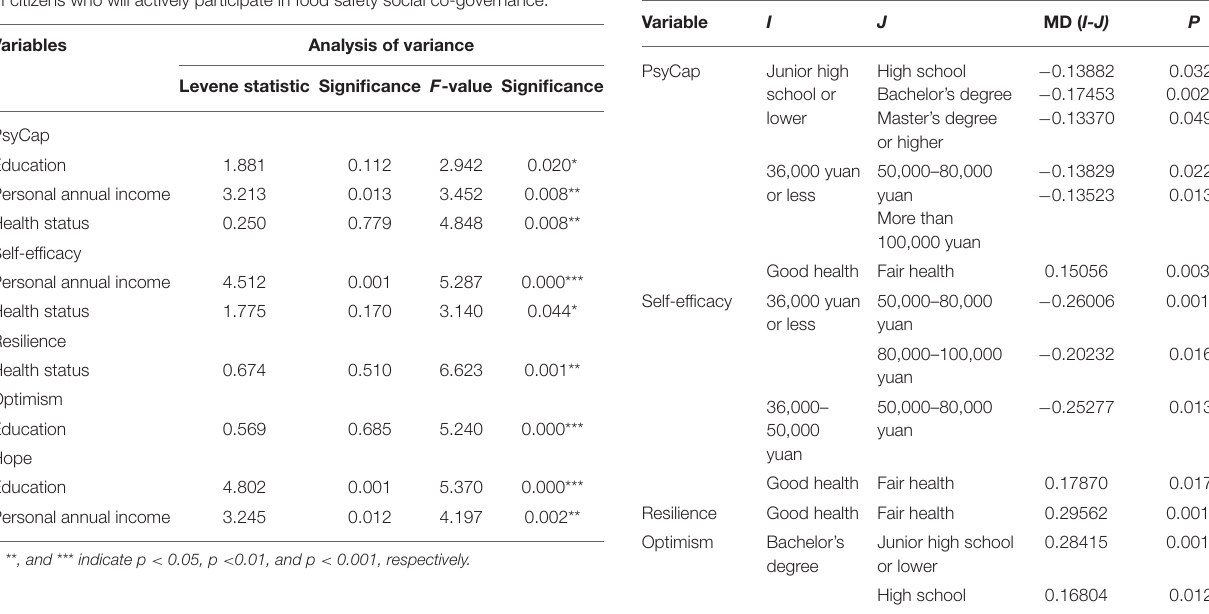
TABLE 9 | Post-hoc multiple